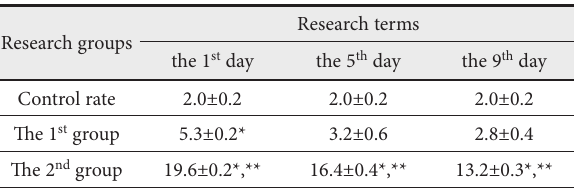
mucositis and dental peri-implantitis